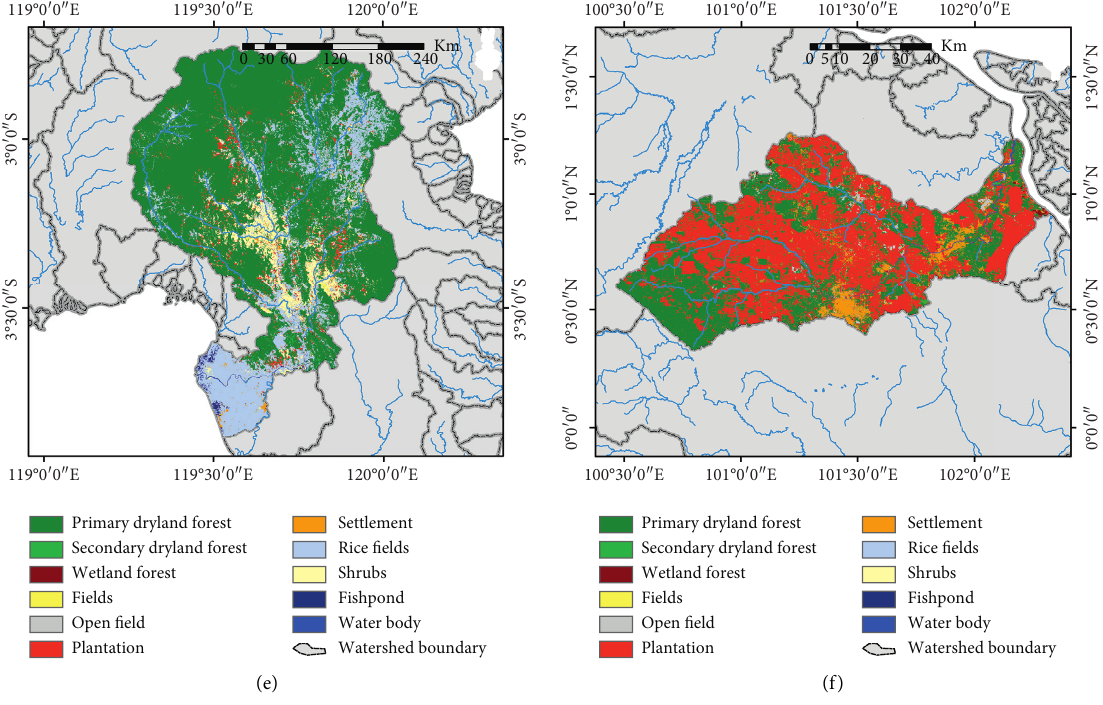
Figure 9: Results of the LULC classification based on the RF classifier: (a, d) Kapuas watershed; (b, e) Saddang watershed; (c, f) Siak watershed; process stage without the MaSegFil approach (a–c); process stage with the MaSegFil approach